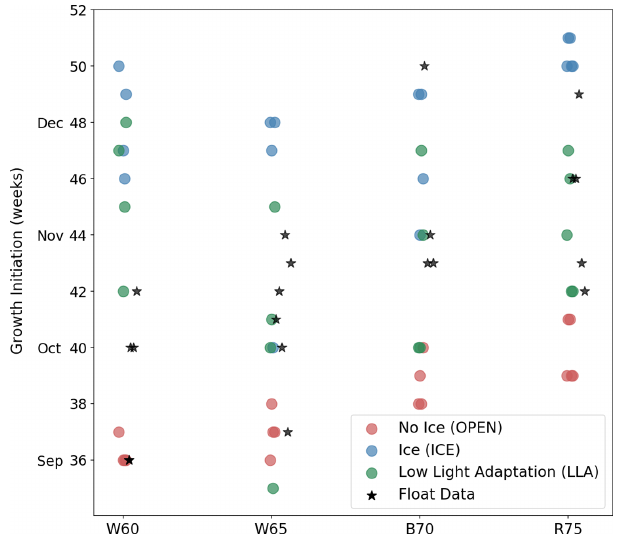
Figure 8. Timing of GI for each study region (horizontal axis) and model experiments (coloured points). Corresponding values from float data are indicated by black